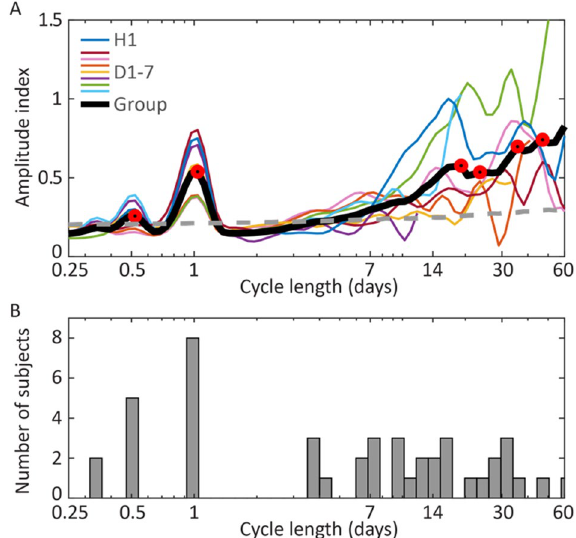
Figure 2. IES rate cycles. ( A ) Hourly average IES rate amplitude spectral density for all subjects and group average. Significant local maxima in the ASD plot are marked by red circles. The grey dashed line marks the 95th percentile of normally distributed white noise. ( B ) Histogram of amplitude spectral density relative maxima above the 95th percentile of normally distributed white noise. The histogram includes significant observed cycles (relative maxima) for all subjects (D1–7 and H1). ASD amplitude spectral density, IES interictal epileptiform spike.